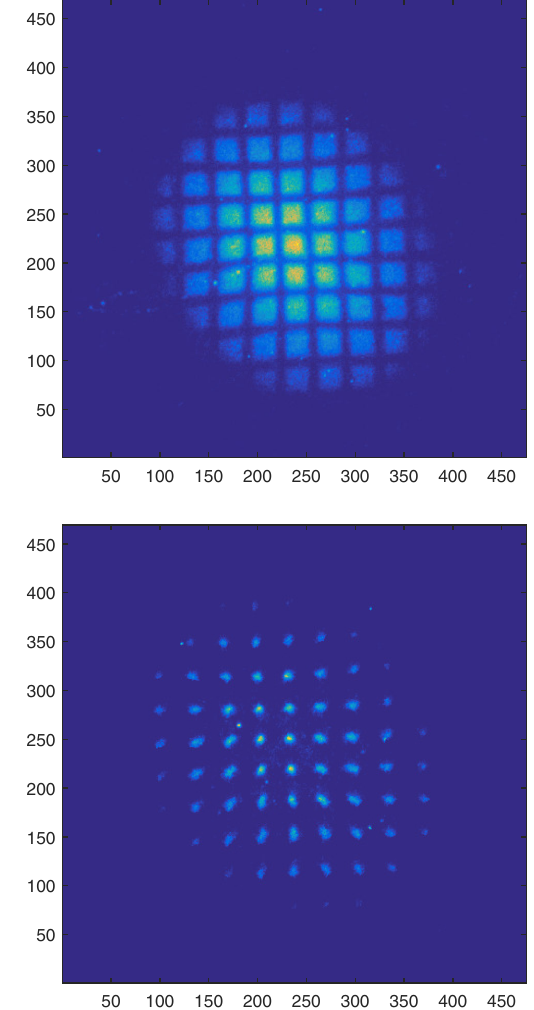
FIG. 10. Sample intensity plot of an image taken in experiments at Pegasus using a TEM grid (top) and a pepper pot (bottom). The images have been cropped to remove the edge of the YAG screen, which was emitting